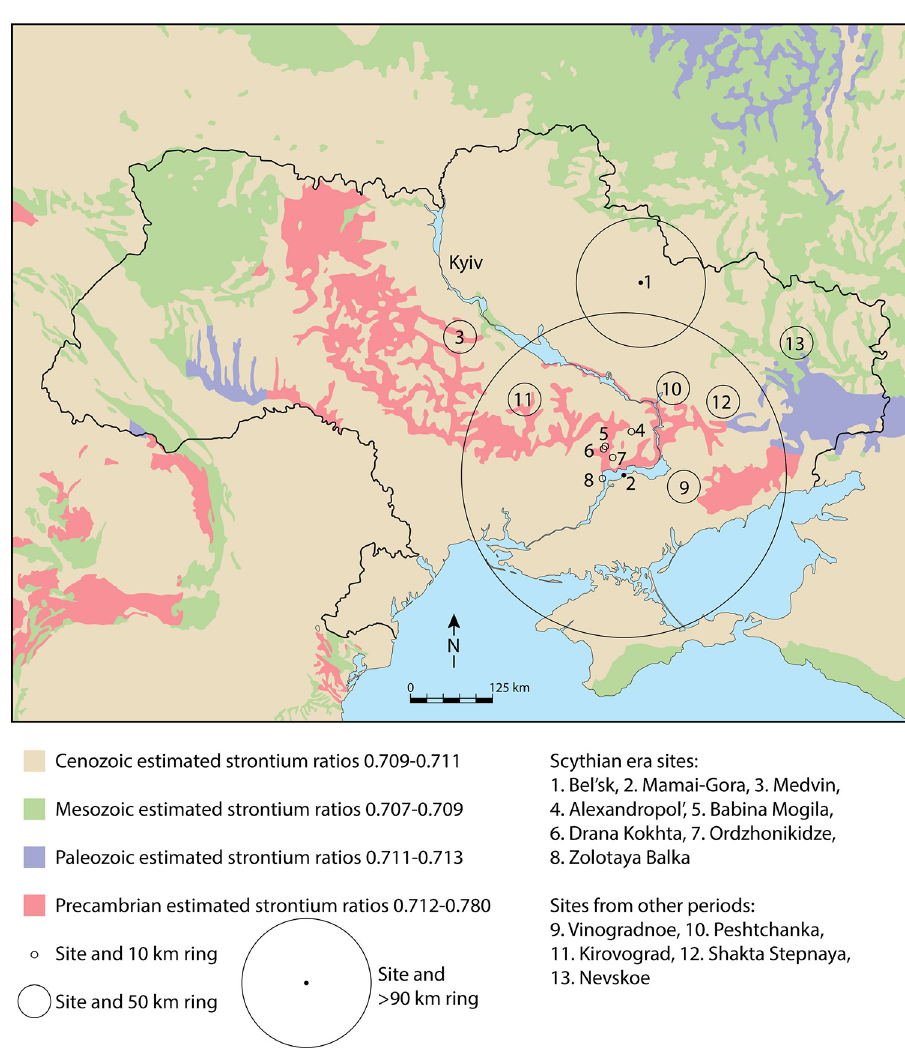
Fig 2. Map of geologic substrates in Ukraine and estimation of the extent of human mobility (circles) at each site. Basemap constructed in Adobe Illustrator CC 2020 from available geologic maps.